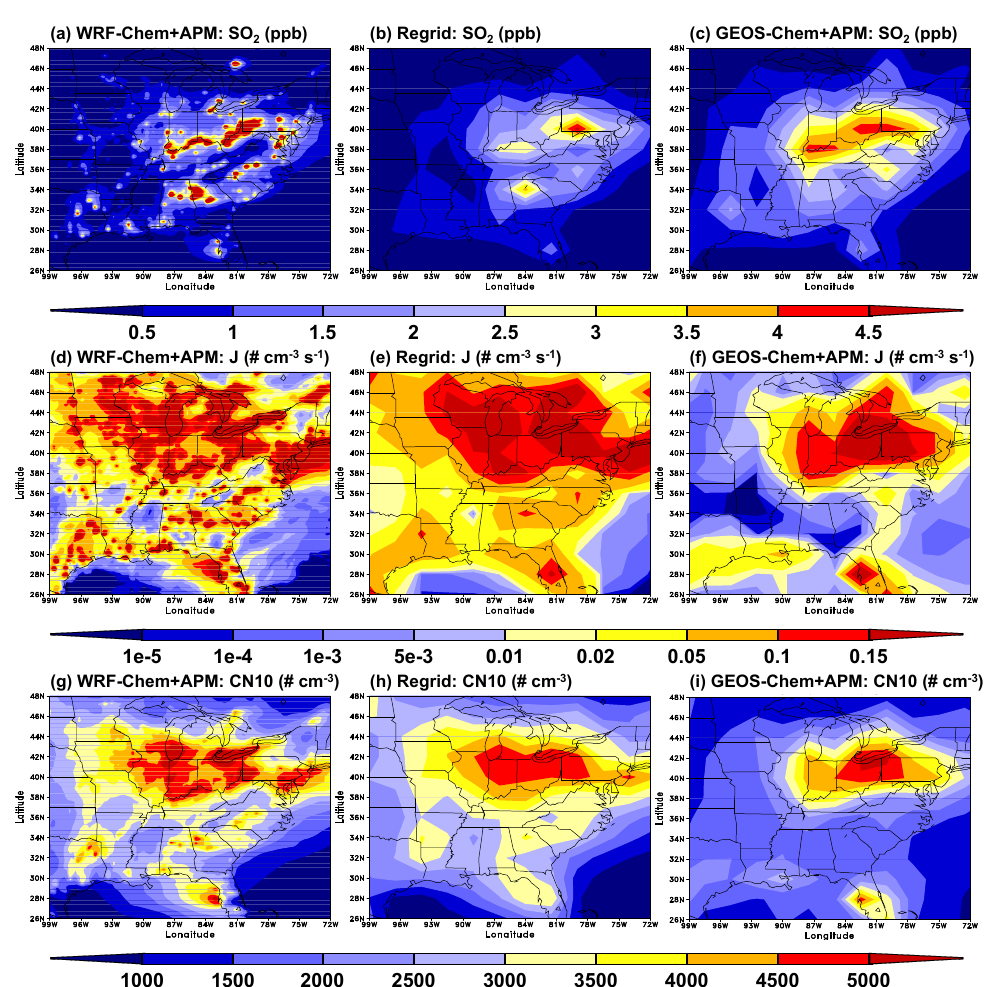
Fig. 5. Simulated horizontal distributions of SO 2 concentrations (a, b, c) , nucleation rates (d, e, f) , and the number concentration of particles larger than 10nm (g, h, i) in the boundary layer ( ∼ 1km) by WRF-Chem+APM, WRF-Chem+APM regrided to the GEOS-Chem horizontal resolution, and GEOS-Chem+APM (2004